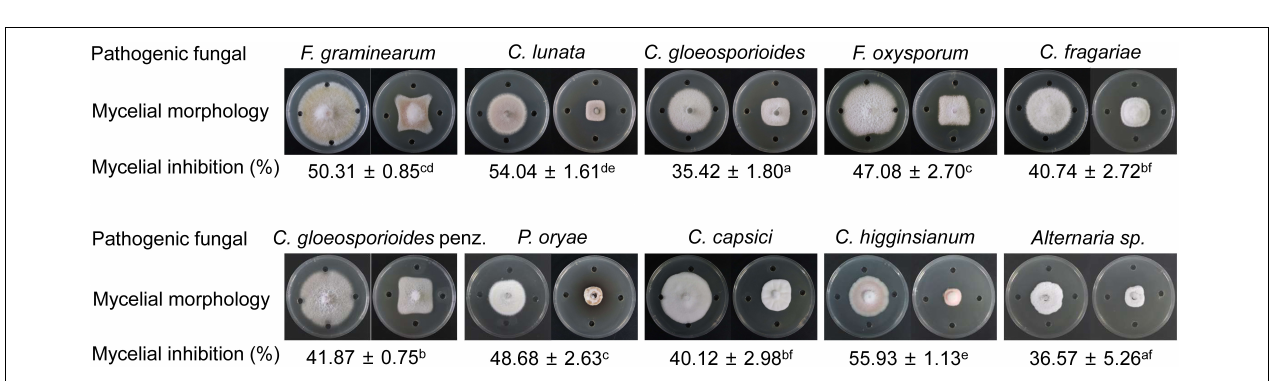
FIGURE 6 | A broad-spectrum antifungal activity of strain QN1NO-4 extract against the selected phytopathogenic fungi.